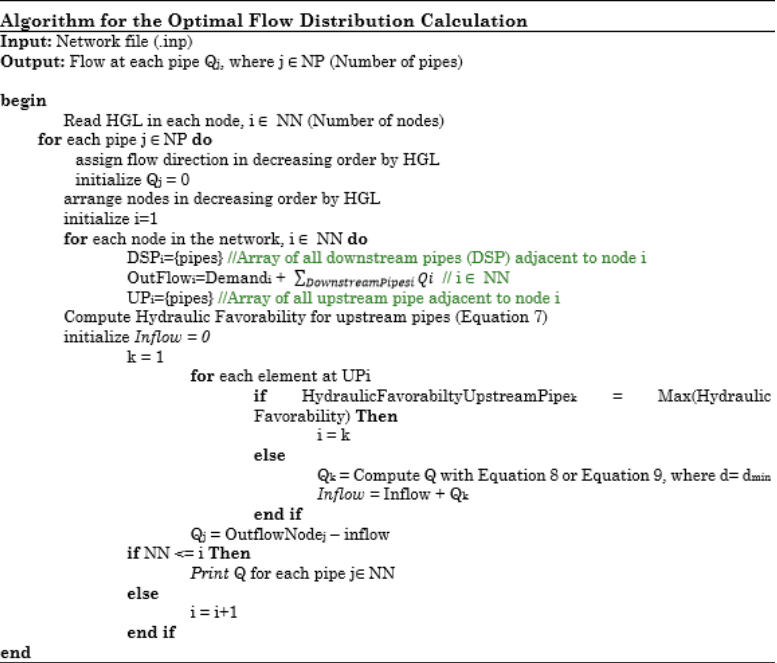
Figure 7. Algorithm for the Optimal Flow Distribution.